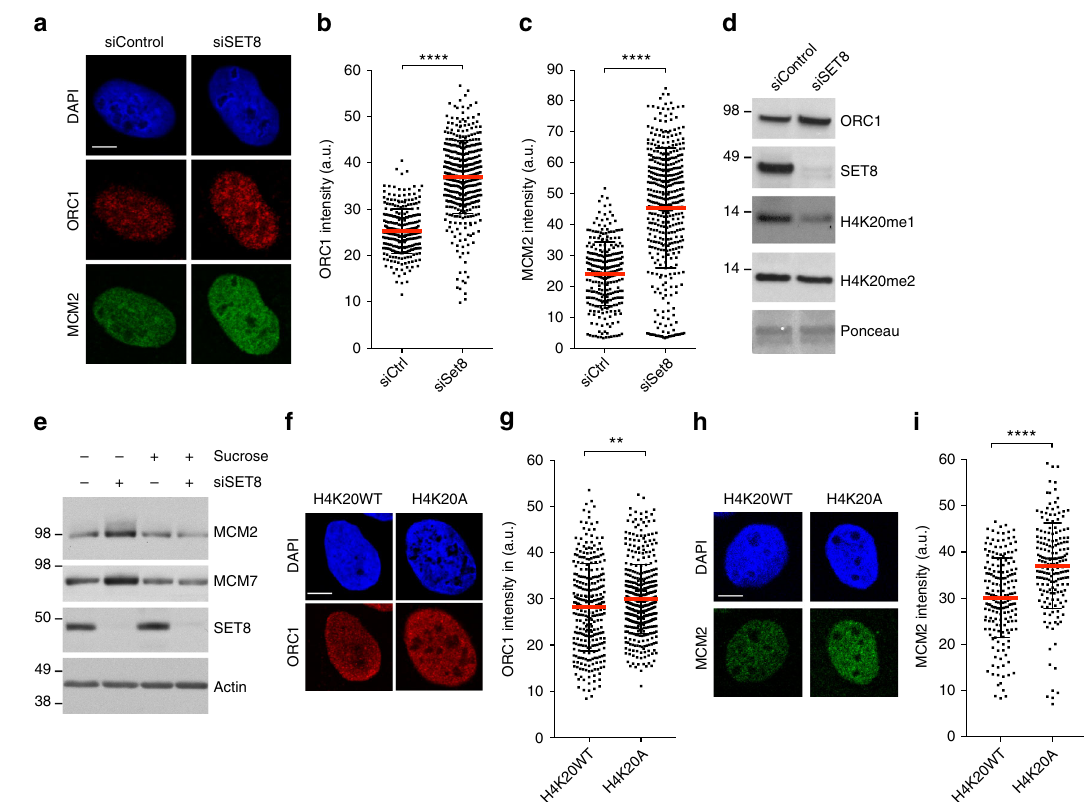
Fig. 3 Chromatin compaction threshold restricts excessive loading of replication licensing factors. a U2OS cells were synchronized with double thymidine block, transfected with either siControl or siSET8 6 h before G1/S release, and fi xed at 15 h post release. Cells were pre-extracted in CSK buffer containing 0.5% triton and immunostained with the indicated antibodies. Cells were counterstained with DAPI (Bar, 10 µ m). b Scatter plot showing the quanti fi cation of ORC1 intensity from cells in a where mean ± SD is indicated by red lines. n > 150, **** p < 0.0001 (unpaired t test). n > 280. c Scatter plot showing the quanti fi cation of MCM2 intensity from cells in a where mean ± SD is indicated by red lines. n > 150, **** p < 0.0001 (unpaired t test). n > 280. d Chromatin fraction was prepared from synchronized U2OS cells depleted as in a , harvested at 15 h, and immunoblotted with the indicated antibodies. e Chromatin was prepared from cells synchronized and transfected with siRNAs as in a , treated with sucrose at 12 h post G1/S release, and harvested at 15 h. Samples were blotted with the indicated antibodies. f U2OS cells expressing DOX-inducible FLAG-HA-tagged histone H4WT or H4K20A mutant were synchronized as in a and fi xed at 15 h post release. Cells were pre-extracted and immunostained with the indicated antibody as well as DAPI for DNA (Bar, 10 µ m). g Scatter plot showing the quanti fi cation of ORC1 intensity from HA-positive cells in f where mean ± SD is indicated by red lines. n > 250, ** p < 0.01 (unpaired t test). h U2OS cells expressing DOX-inducible FLAG-HA-tagged histone H4WT or H4K20A mutant were synchronized as in a and fi xed at 15 h post release. Cells were pre-extracted and immunostained with the indicated antibody as well as DAPI for DNA (Bar, 10 µ m). i Scatter plot showing the quanti fi cation of MCM2 intensity from HA-positive cells in h where mean ± SD is indicated by red lines. n > 180, **** p < 0.0001 (unpaired t